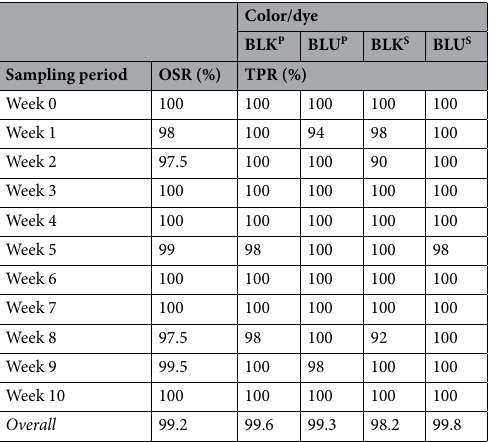
Table 1. Class prediction models of each dye for each week, featuring the true positive rate (TPR) indicating the accuracy of the program to predict that color among the rest and the overall success rate (OSR) of the program’s ability to predict all colors each week.